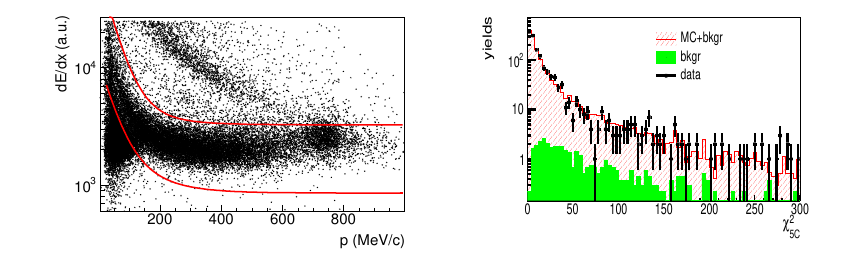
Figure 1. (left) Ionization losses vs. momentum for positive tracks for data at E c . m . = 1 . 5 GeV. The lines show the acceptance for signal pions. (right) The spectrum of χ 2